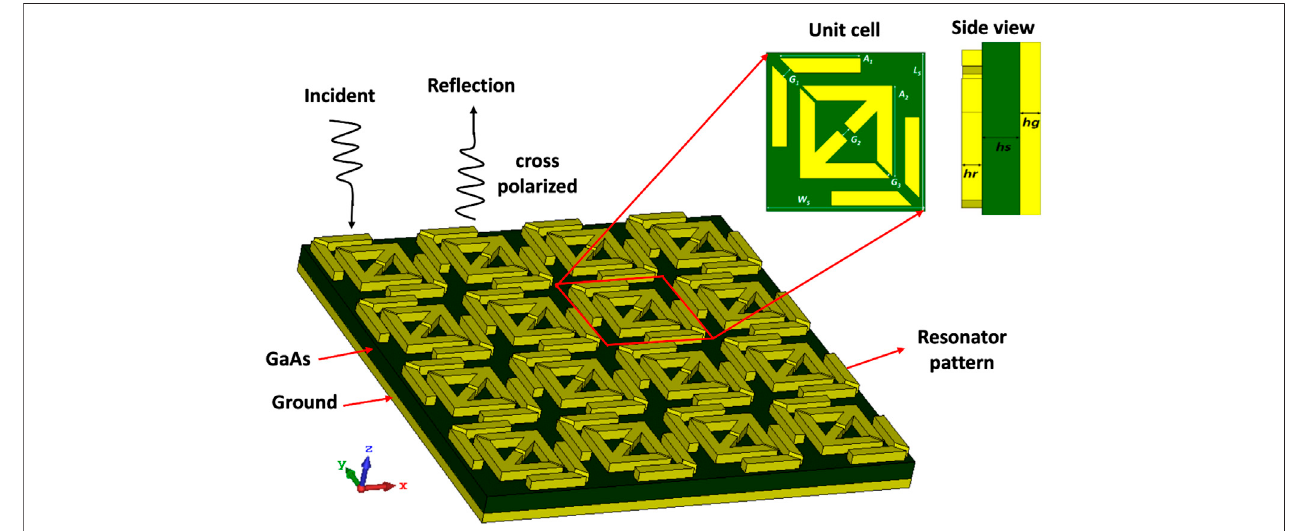
FIGURE1| Schematicprototypeoftheproposedmetasurface polarization converter withthefront andsideviewsoftheunit cellintheinset fi gure.Thedarkgreen and yellow parts represent GaAs and Al, respectively.